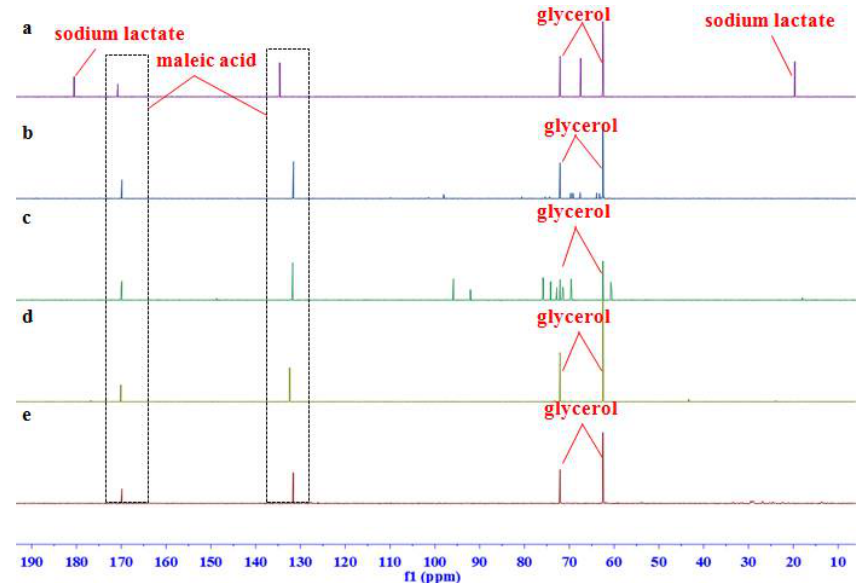
Figure 3. Representative 13 C NMR spectra of ( a ) homemade testing sample; ( b ) glycerol fructose and sodium chloride injection (GFS); ( c ) Shenxiong glucose injection (SXG); ( d ) Xiaozhiling injection (XZL); and ( e ) etomidate injectable emulsion (EIE).